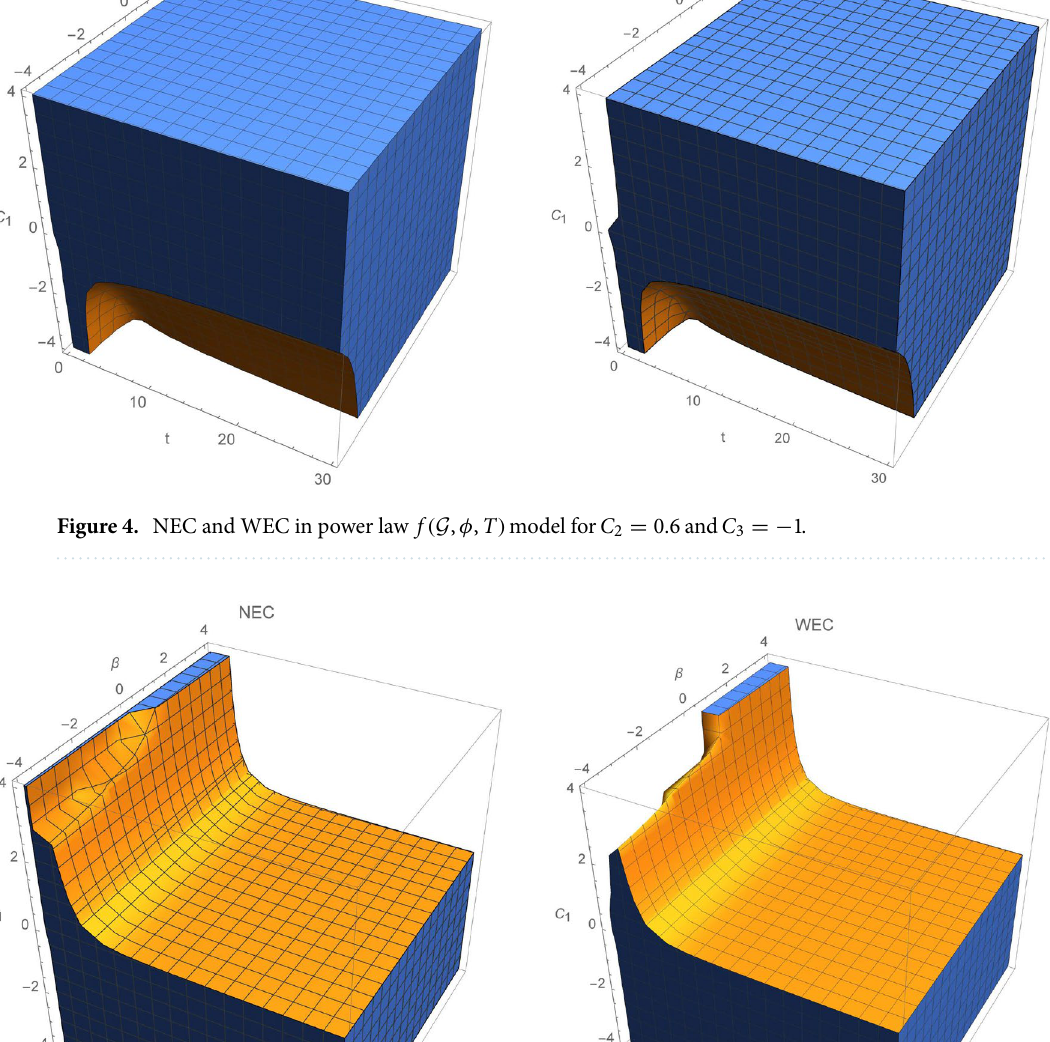
Figure 5. NEC and WEC regions for C 2